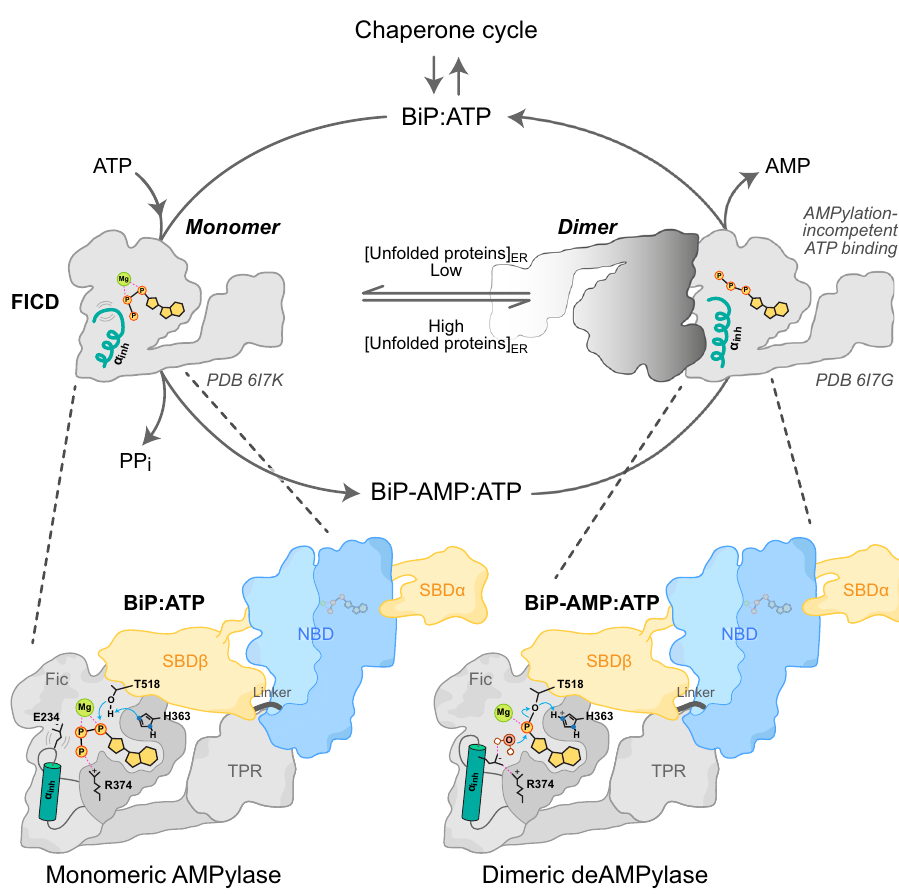
Fig. 8 Model of FICD AMPylation and deAMPylation of BiP. FICD ’ s TPR domain and catalytic Fic domain recognise, respectively, the linker-docked NBD and the ℓ 7,8 region of the SBD β of either AMPylated or unmodi fi ed BiP. Simultaneous engagement of both interfaces is only possible when BiP is in a domain-docked ATP-like state. Dimeric FICD has a relatively rigid gatekeeper Glu234 that facilitates ef fi cient alignment of an attacking water for BiP deAMPylation and inhibits AMPylation competent binding of ATP. Enhanced fl exibility of monomeric FICD ’ s Glu234 decreases deAMPylation ef fi ciency whilst permitting AMPylation competent binding of MgATP by monomeric FICD. We speculate that the FICD monomer-dimer equilibrium is adjusted in response to changing levels of unfolded proteins within the ER by processes which may include a direct response to changes in the ER energy status (ATP/ ADP ratio) 19 . Further details of the FICD-catalysed deAMPylation reaction are presented in Supplementary Fig.